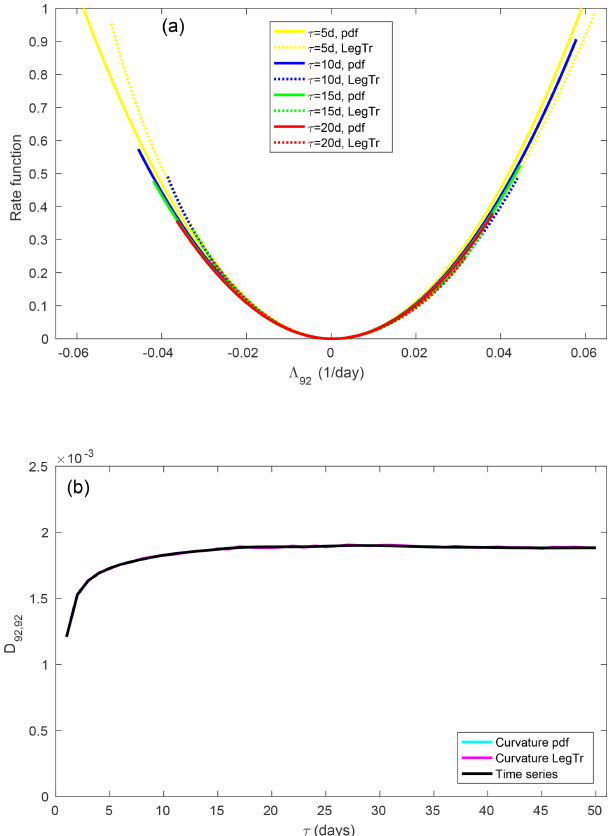
Figure 8. (a) Large-deviation rate function of the fifth FTLE. (b) El- ement D 5 , 5 of the diffusion matrix. Figure 9. (a) Large-deviation rate function of the 92th FTLE.